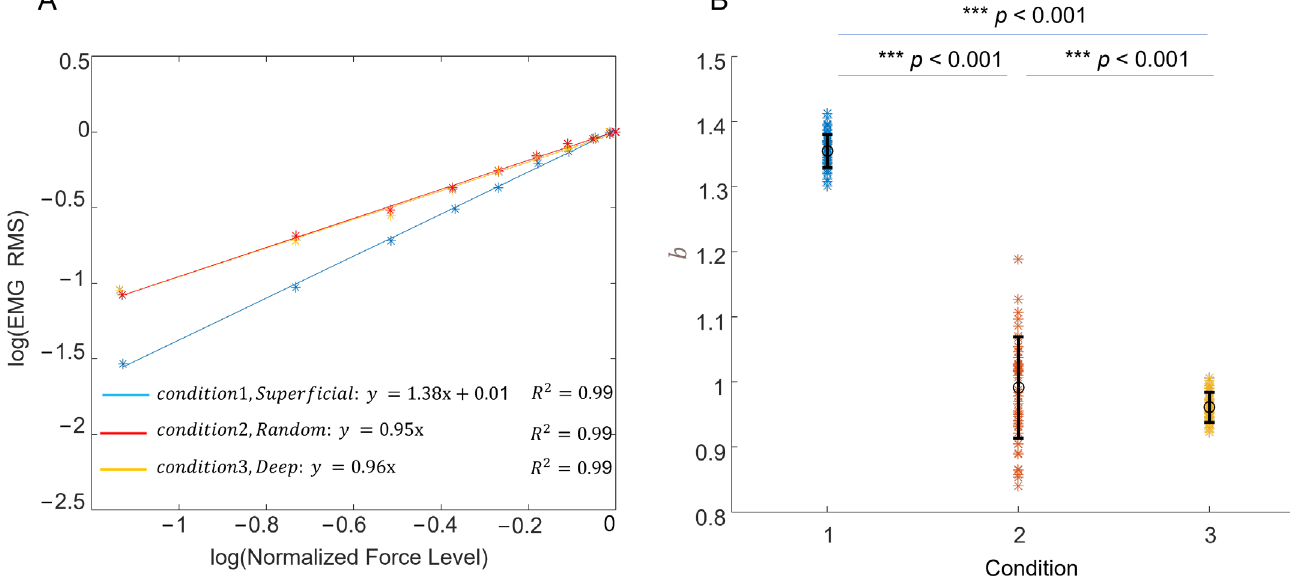
Figure 4. ( A ) Representative examples of log transformed EMG RMS–force relation when large mo- tor units were assumed to preferentially located in the superficial or deep regions of the muscle or unrelated to muscle depth (random). ( B ) The results for b of all the repetitions in each simulated